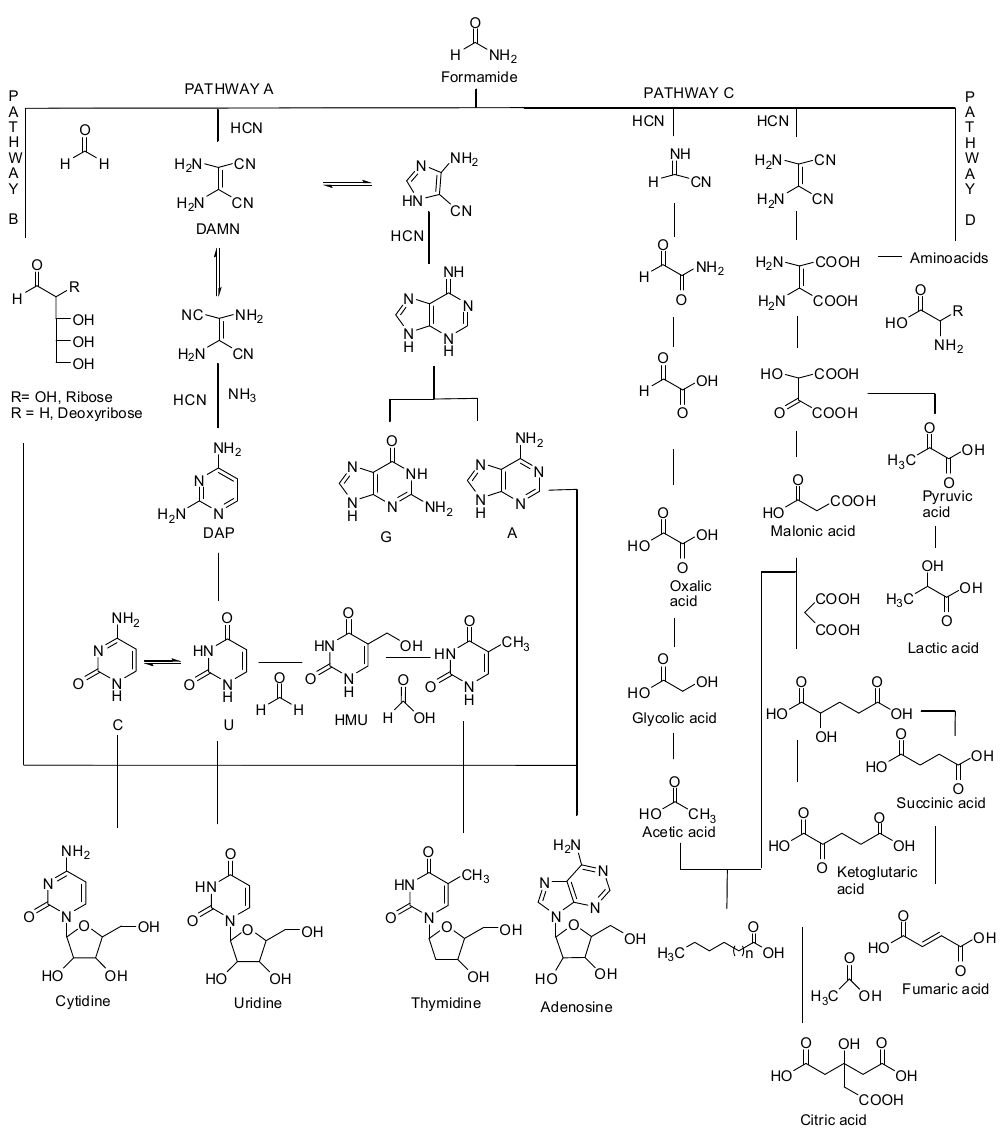
Figure 6. Cascade of chemical transformations affording biomolecules from formamide under proton irradiation conditions in the presence of meteorites. (Pathway A) HCN-mediated formation of nucleobases and nucleotides. (Pathway B) Formaldehyde-mediated aldolformose-like condensation to sugars. (Pathway C) HCN-mediated lactate-like and malonate-like condensations to carboxylic acids and di-carboxylic acids. (Pathway D) Strecker condensation to afford aminoacids.